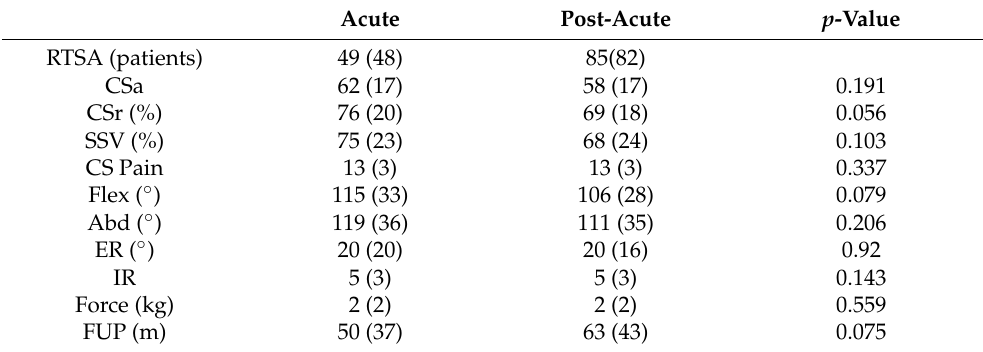
Table 3. Subgroup analysis acute proximal humeral fracture vs. post-acute proximal humeral fracture (>6 weeks post-trauma) of outcome scores and range of